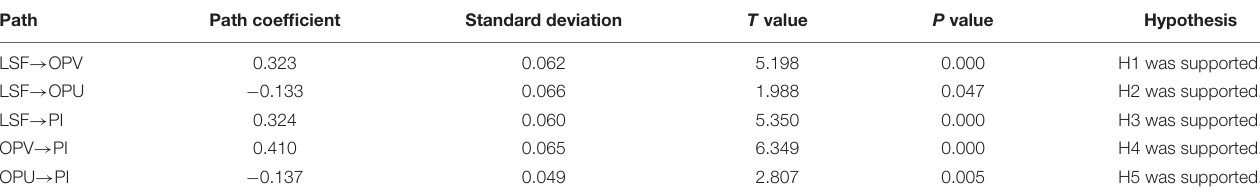
TABLE 4 | Main effects